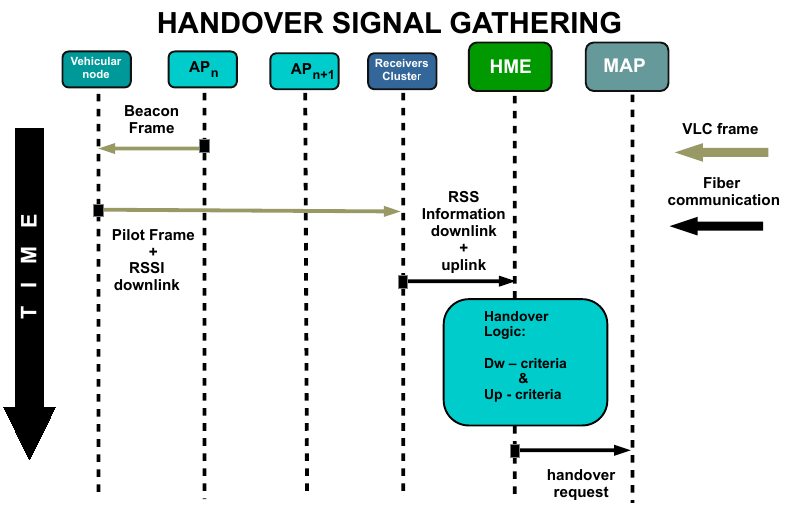
Figure 7. Signal gathering